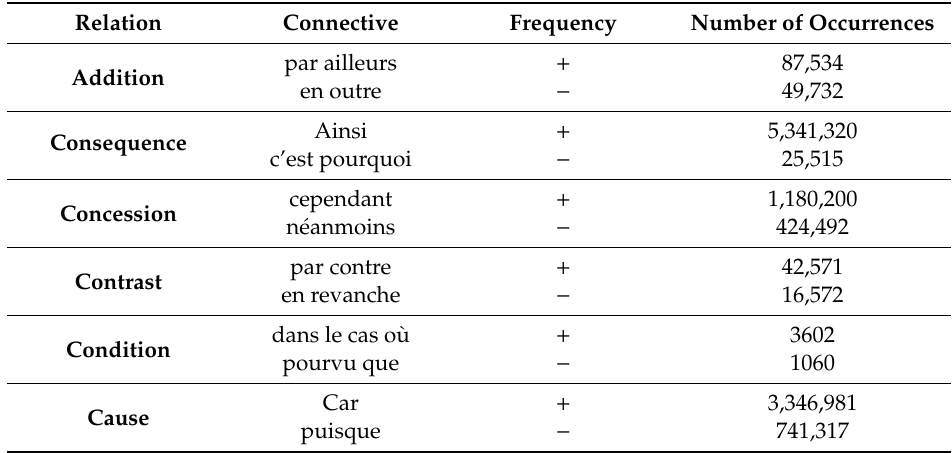
Table 1. Frequency of the used connectives in the corpus French Web 17 determined by an analysis using SketchEngine. For the connectives “pourvu que” and “puisque” apostrophized variations (i.e., “pourvu qu’”, “puisqu’”) are also included. Relation Connective